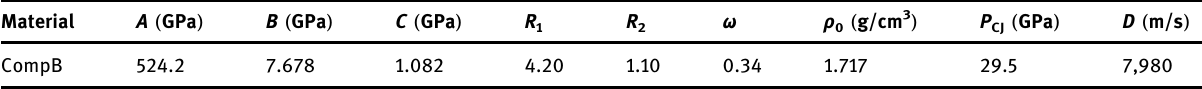
Table 3: JWL parameters and C – J parameters of the CompB explosive Material